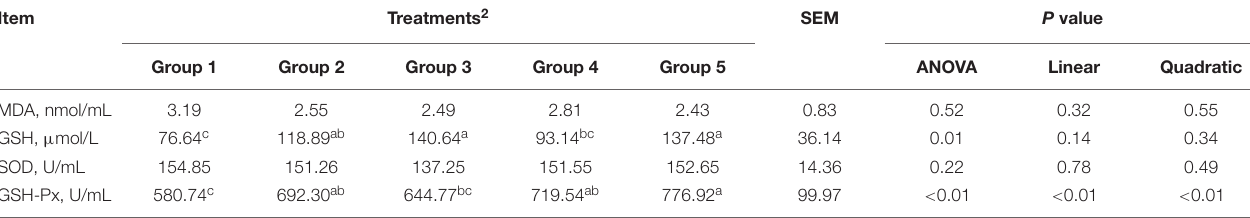
TABLE 3 | Effect of different dietary FA supplementation on antioxidative parameters of experimental ducks 1 .